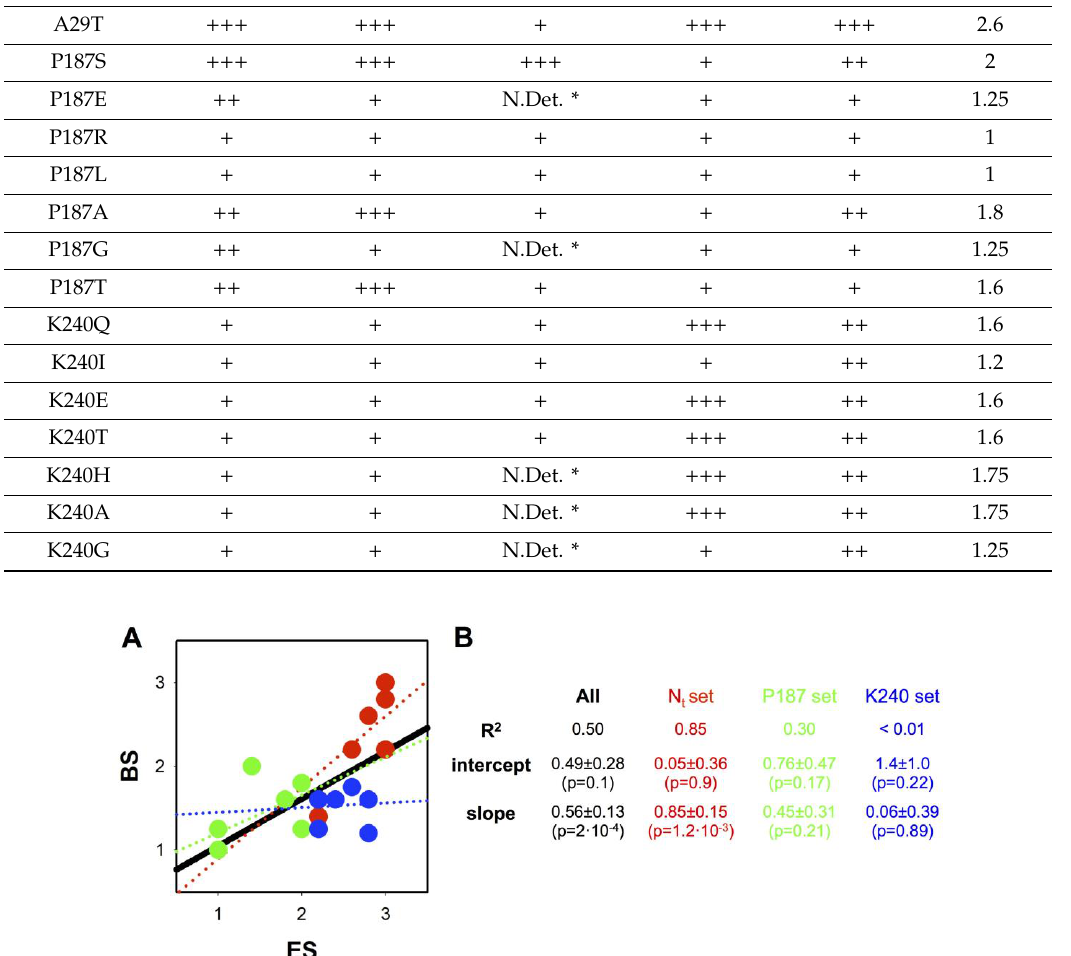
Figure 10. Correlation between experimental scores (ESs) and bioinformatic scores (BSs). ( A ) Plot of ES vs. BS for all mutants compiled in Tables 3 and 4. Red circles show mutants belonging to the Nt set (the eight mutants characterized in this work) and green and blue circles show mutants belonging to mutations at the P187 and K240 sites, respectively ( P187 and K240 sets , see Tables 3 and 4 [39]). The thick black line is the linear regression of all mutants, while dotted lines are linear fittings using one of the three sets (N t , P187 or K240 sets; red, green and blue lines, respectively). ( B ) Best-fit parameters for linear regressions are shown in panel B.